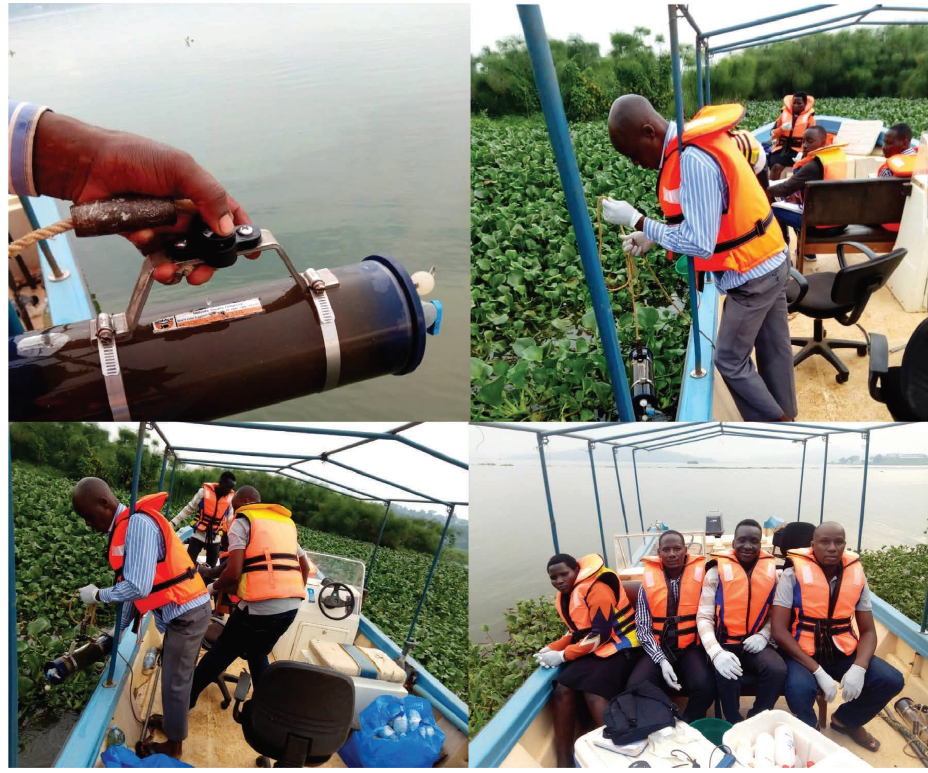
Figure 3: Water sample collection during the feld study (source: